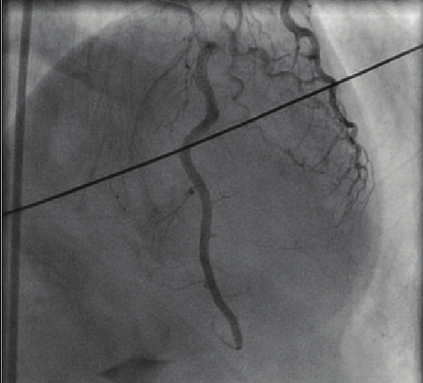
Figure 2: Cardiac catheterization demonstrating severe mid to distal LAD occlusion.